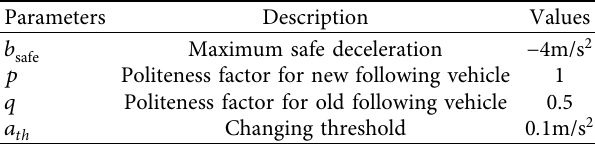
Table 3: Parameters setting of MOBIL.